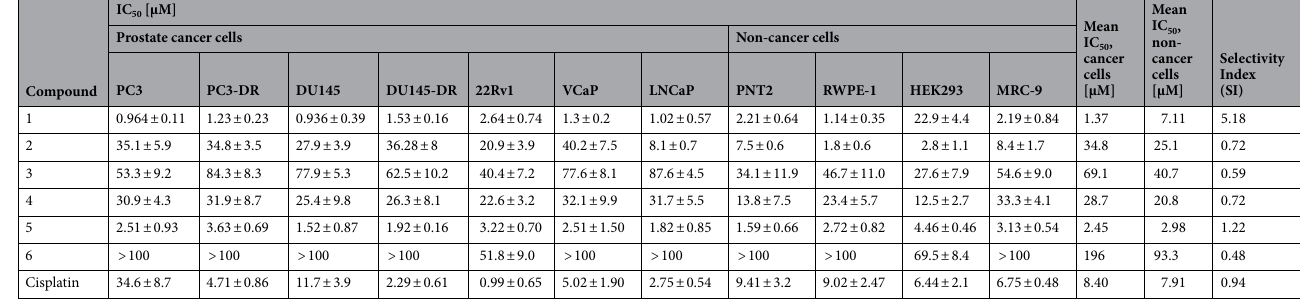
Table 2. Cytotoxic activity and selectivity of the isolated compounds. IC 50 s were determined using MTT assay after 48 h of treatment. The values are represented as mean ± SD. Selectivity index (SI) was calculated as [mean IC 50 in non-cancer cells]/[mean IC 50 in cancer cells]. Cisplatin was used as a reference